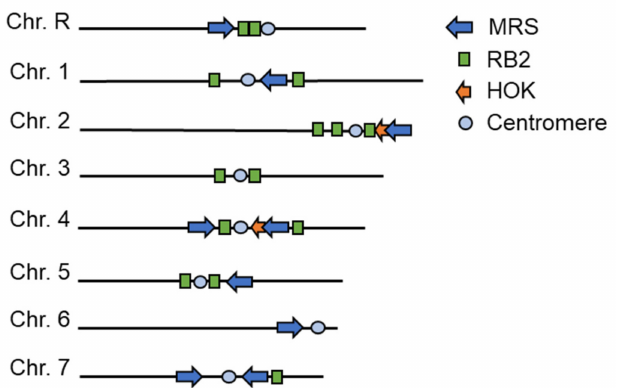
Figure 4. MRS elements in the C. albicans genome. The nine complete MRS loci (blue), 14 RB2 elements (green) and two HOK elements (orange) have been placed on their relative chromosome positions in C. albicans strain